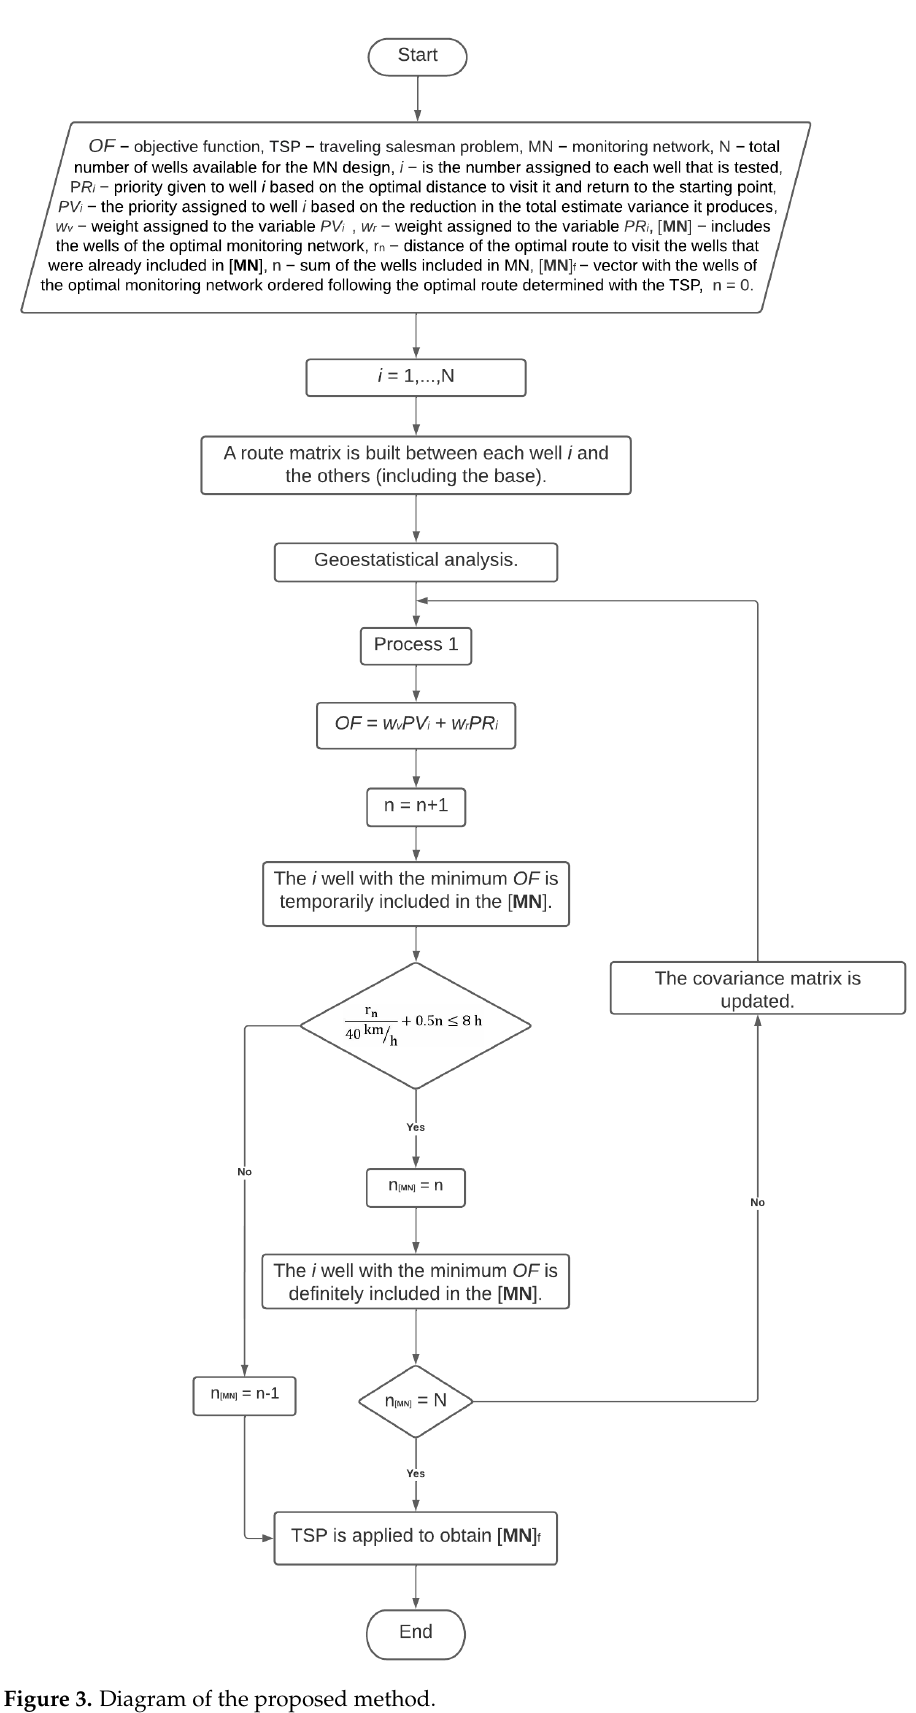
Figure 3. Diagram of the proposed